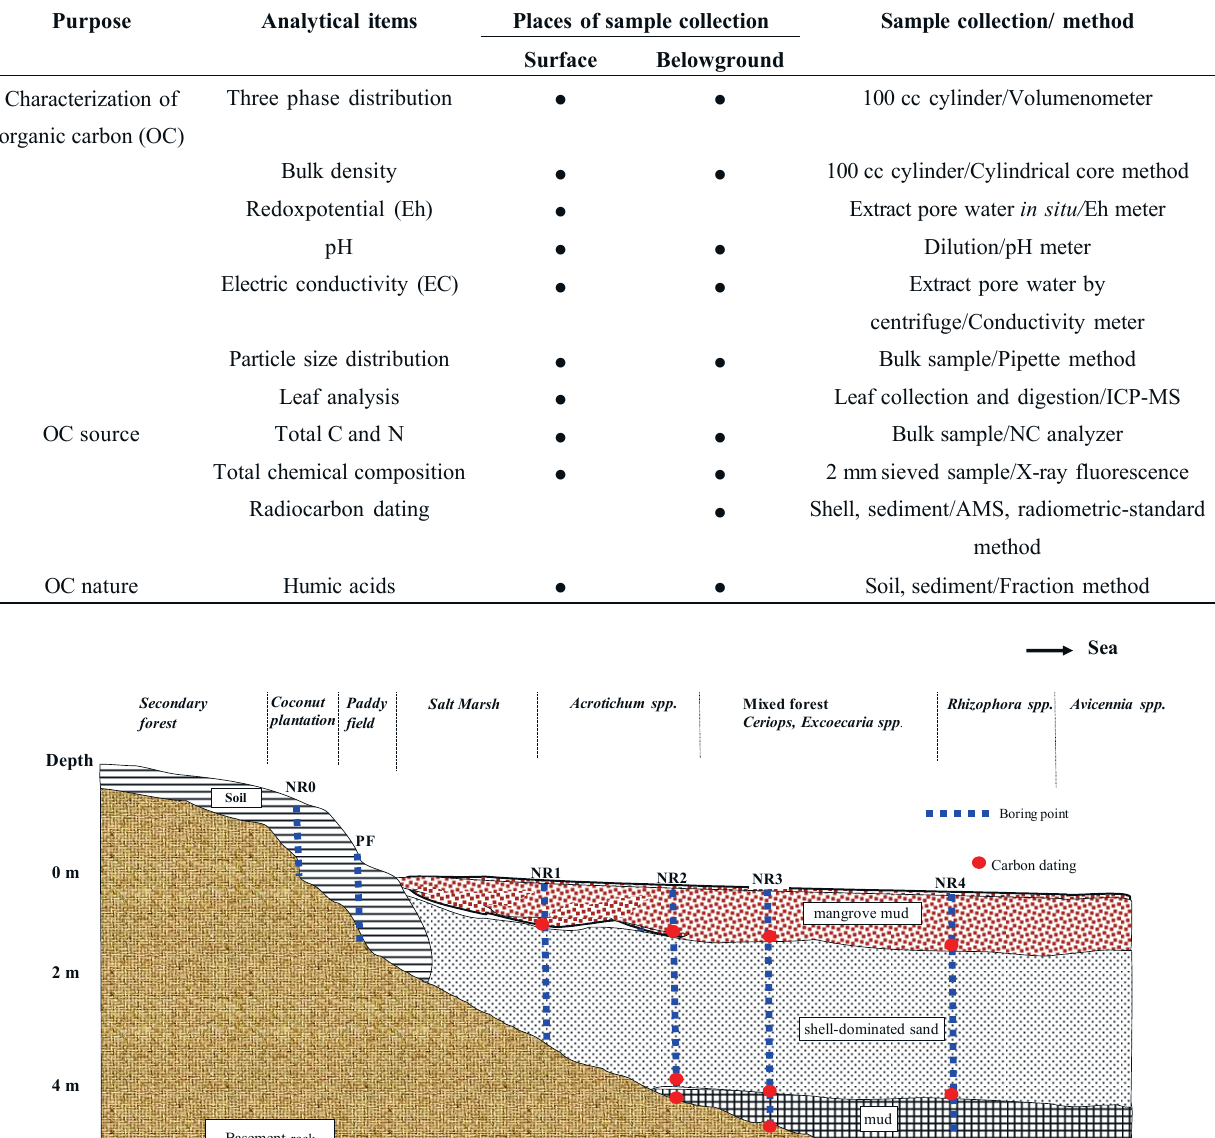
Table 1. Purpose of analysis, analytical items, places of soils/sediments sample collection and the methods of sample and analysis.